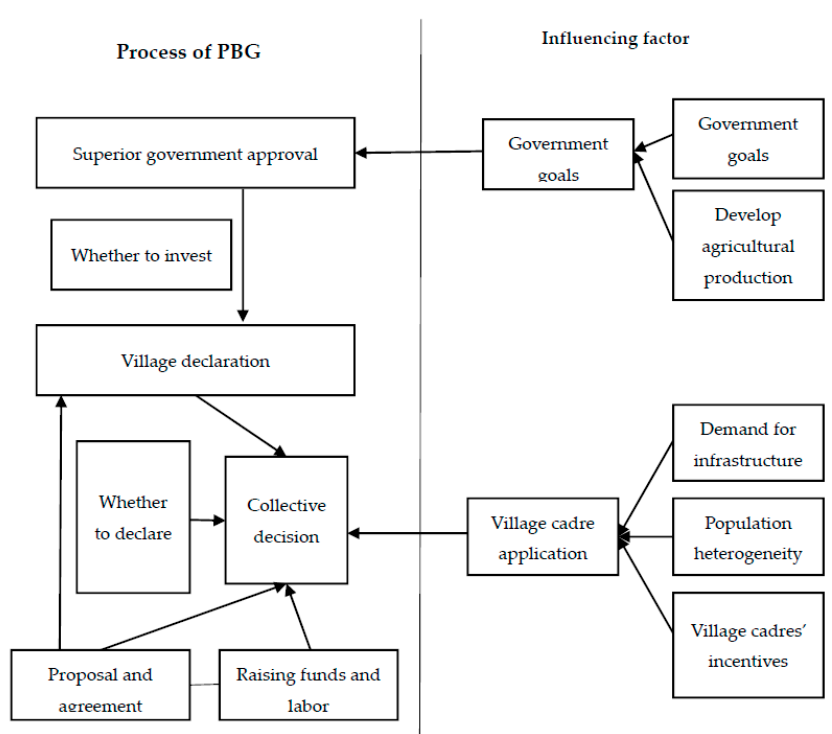
Figure 2. Analysis of the process and influencing factors in PBG.